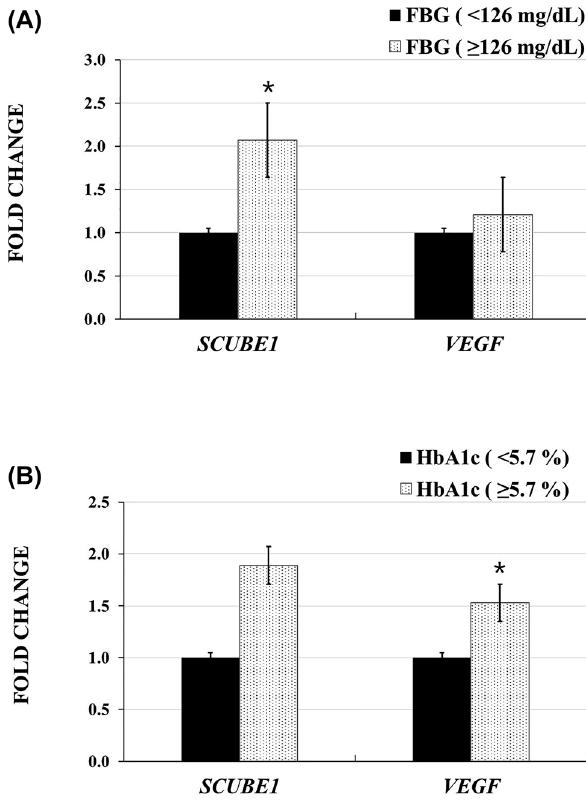
Figure 2: Comparison of SCUBE1 and VEGF gene expression levels according to FPG (A) and HbA1c (B) levels. FPG, fasting plasma glucose; HbA1c, hemoglobin A1c.